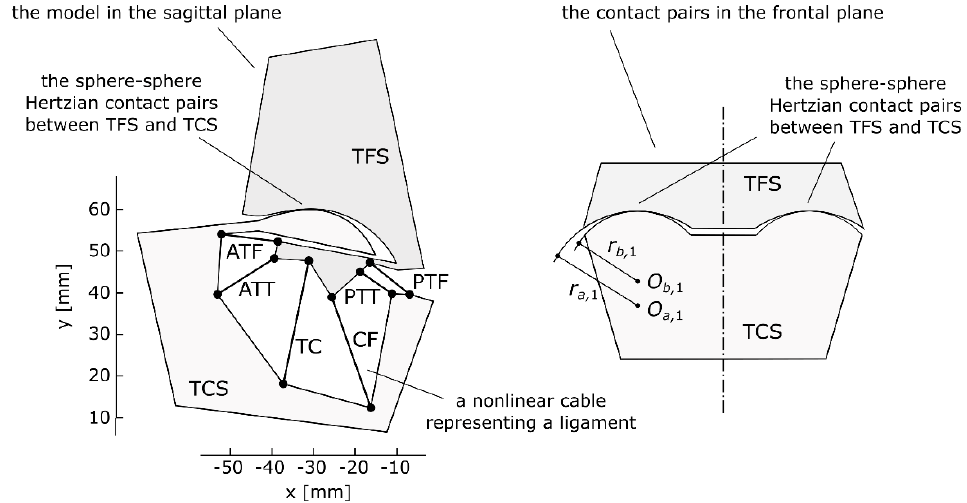
Figure 1. Assumed planar model of the ankle joint in the sagittal plane and a schematic representation of its spherical contact pairs, reproduced with permission from [26].